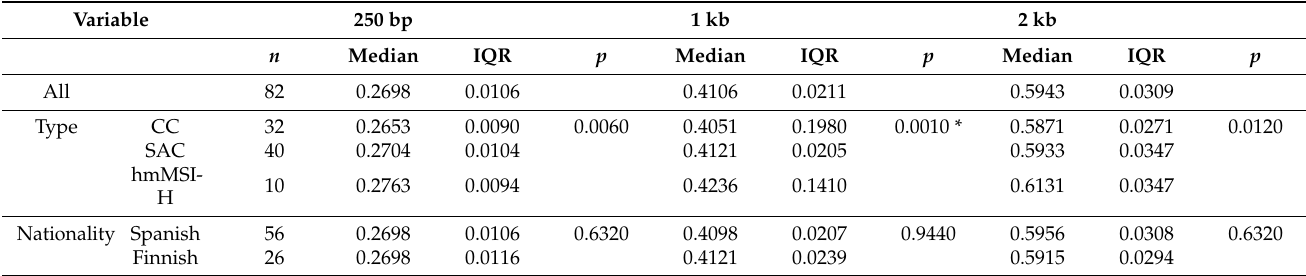
Figure 3. Global methylation scores for each tumor histological subtype. CC: conventional carcinoma, SAC: serrated adenocarcinoma, hmMSI-H: colorectal cancer showing histological and molecular features of high level of microsatellite instability. * p < 0.05, ** p < 0.01, *** p < 0.001. Table 3. Association of global methylation scores in tumor specimens with demographic, clinic-pathological and histologic features of the study